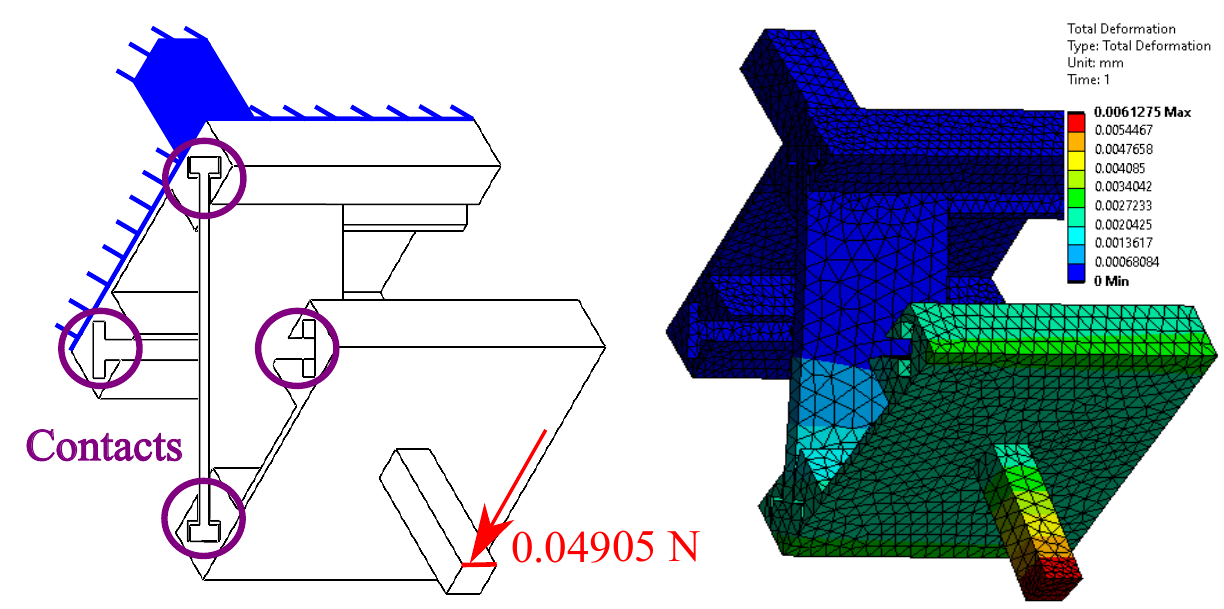
Figure 5. Left : isometric view of the boundary conditions showing the fixed part (blue), the force applied (red), and the contact zones (purple). Right : representative FE simulation of the compliant joint cross-axis in Ansys Workbench ® . Color map represents